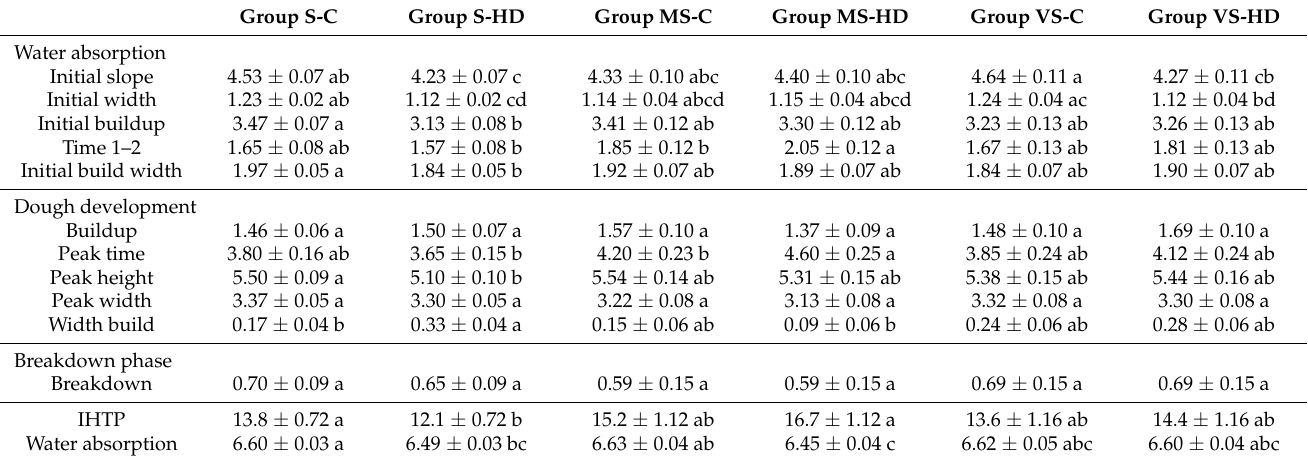
Table 2. Tukey’s post hoc test ( p < 0.05) of dough mixing characteristics of groups (S—stable, MS— moderately stable, and VS—varying stability) of 56 spring wheat genotypes grown in cool (C, 2017) and heat–drought (HD, 2018) years. Data are presented as means ± standard errors, calculated from three replicates for each